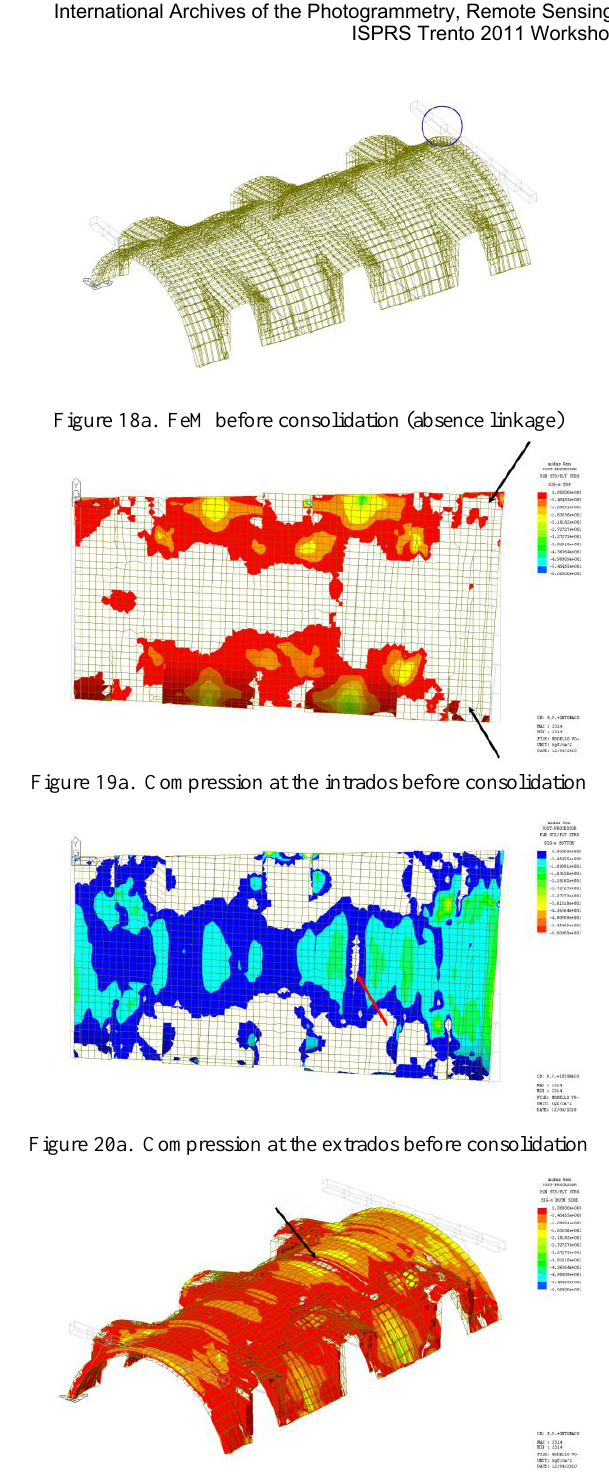
Figure 21b. Development of compression after consolidation